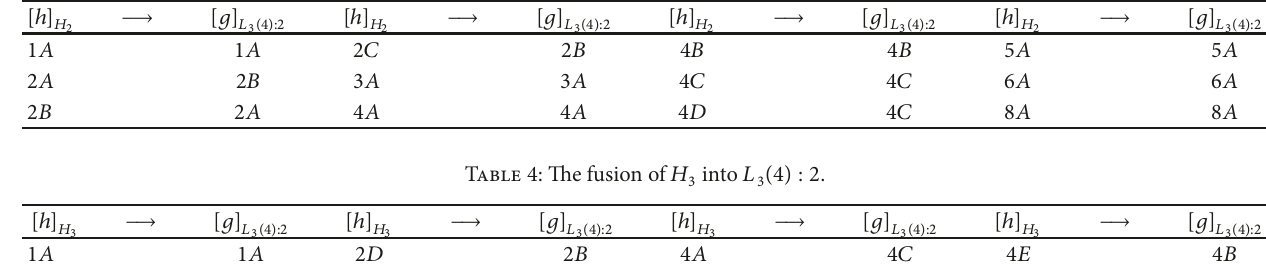
Table 3: The fusion of 𝐻 2 into 𝐿 3 (4) : 2 .